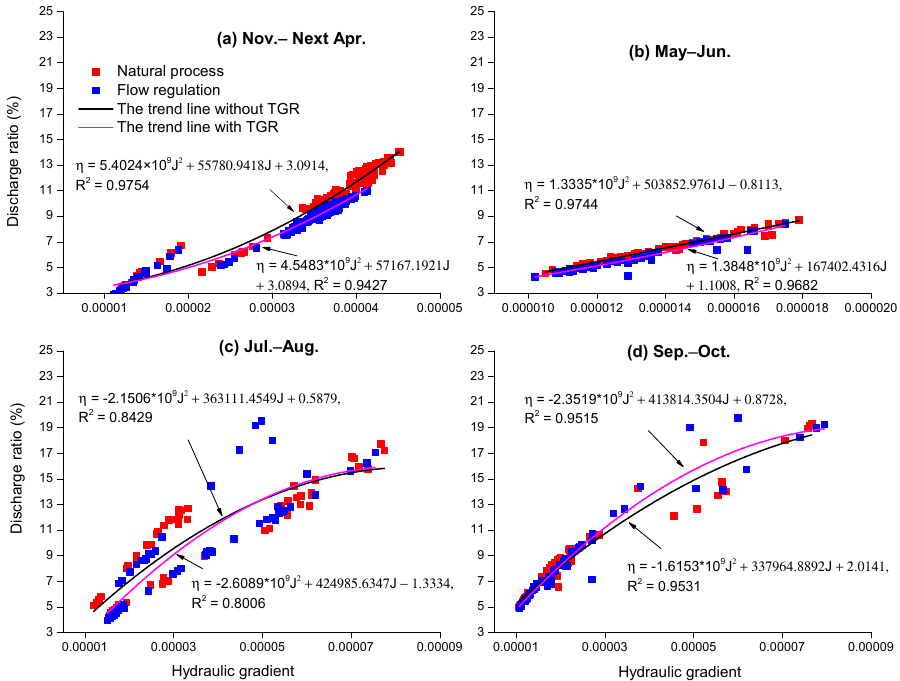
Figure 11. Relationship between the discharge ratio and hydraulic gradient near the Han River estuary during the different scheduling periods of the TGR. η denotes the discharge ratio and J is the hydraulic gradient at the gauging stations.